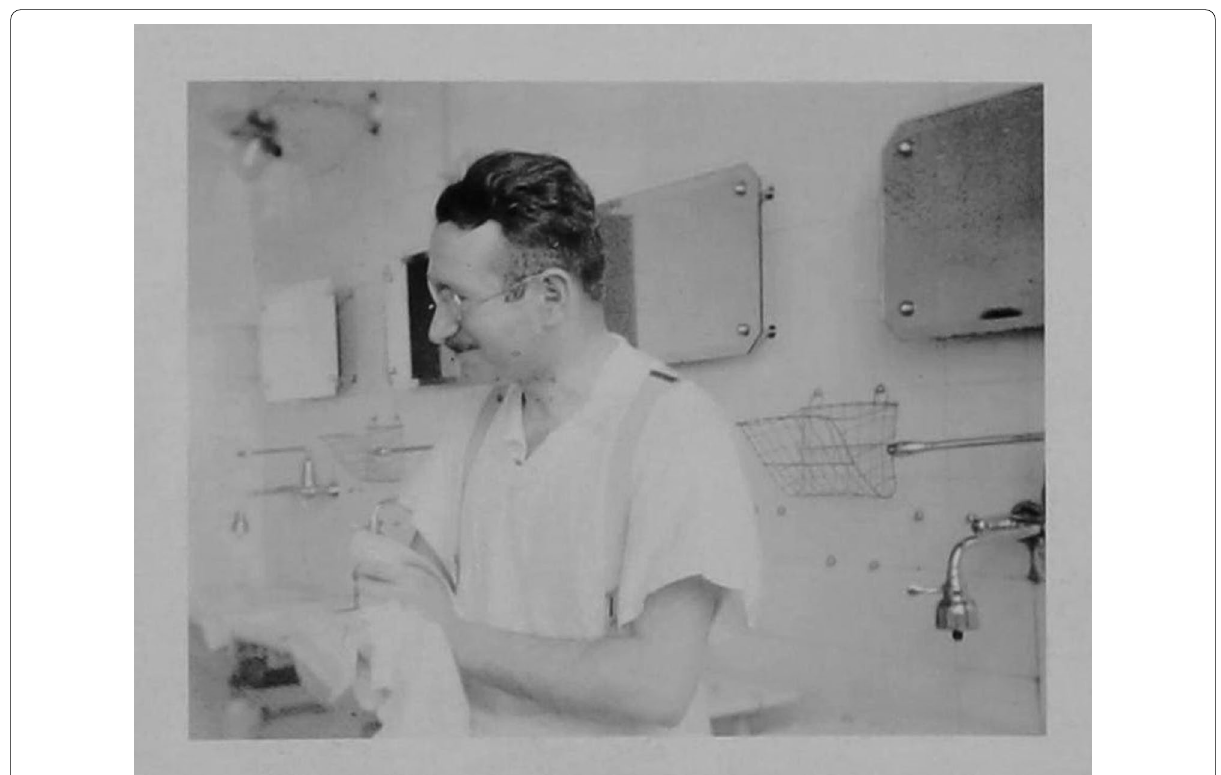
Fig. 4 Ludwig Guttmann at a younger age. Undated photography, photographer unknown. Source : Wellcome Collection, Ludwig Guttmann archive collection. With